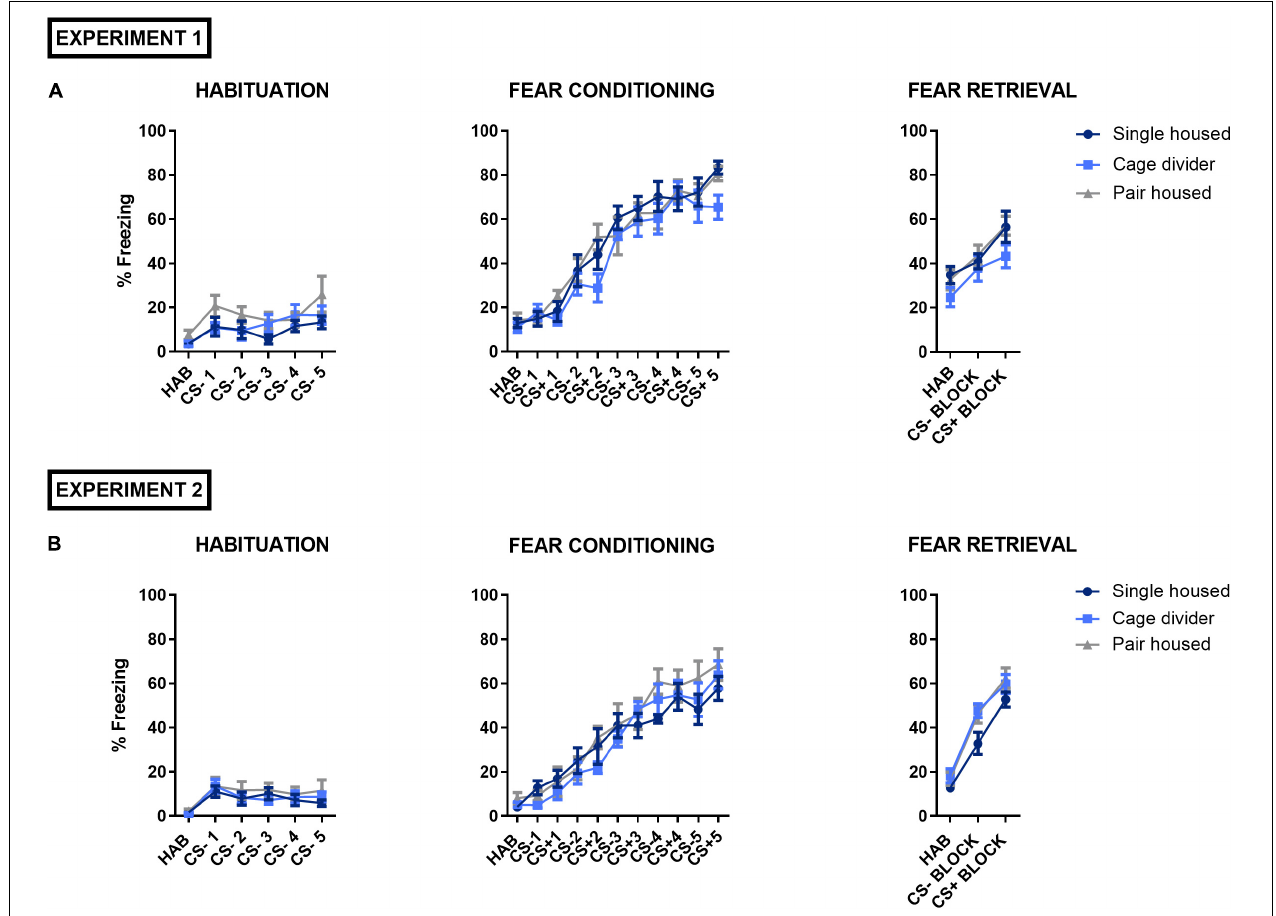
FIGURE 4 | Auditory fear conditioning in mice that are single housed, pair housed and pair housed with a cage divider. The graphs illustrate the freezing responses of mice during the acclimation period (HAB) or evoked by cue presentation (CS − , CS + ) during the habituation session to CS − , auditory fear conditioning and fear retrieval test. (A) Overview of the fear conditioning procedure in experiment 1. (B) Overview of the fear conditioning procedure in experiment 2. Data are presented as mean ± SEM. n = 10 mice/housing condition. Freezing scores during CS − and CS + presentation are presented as the average of four tone presentations during the fear retrieval test. Statistical analysis: Repeated measures Two-Way